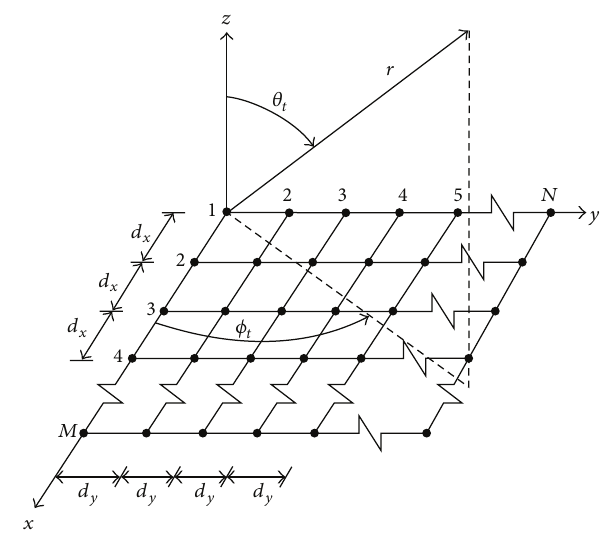
Figure 3: 𝑀 × 𝑁 planar array